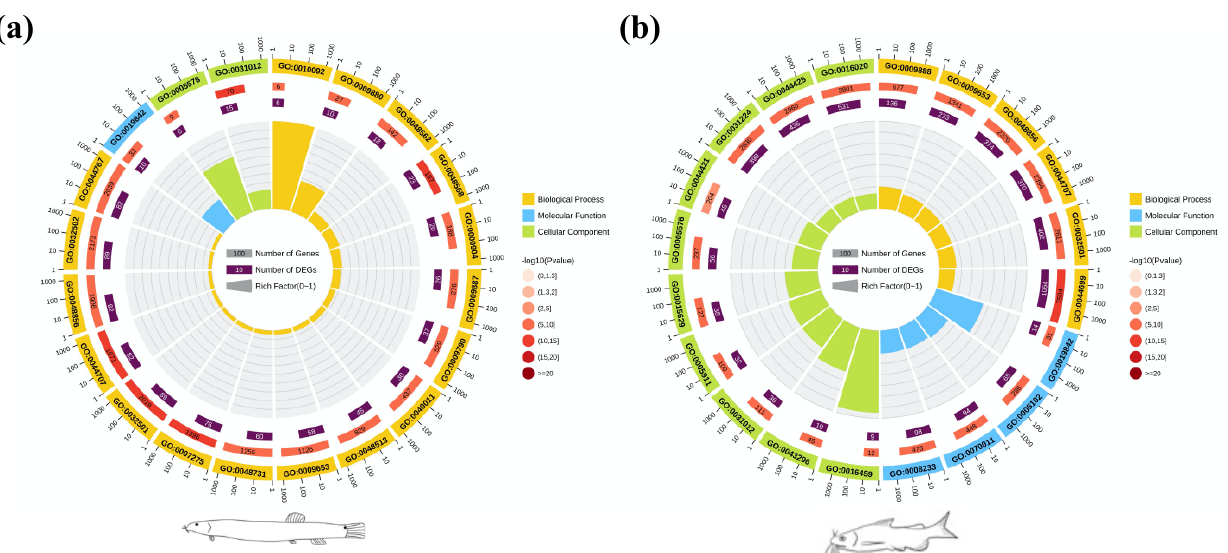
Figure 3. Top 20 of GO classifications enriched in the differentially expressed genes (DEGs) in comparisons of RS/OS pertain to loach ( a ) and yellow catfish ( b ). RS: regenerated skins; OS: original skins. The first circle from outside indicates gene number scale and GO items present by GO ids; Second circle indicates gene numbers under each GO item, and third circle shows enriched gene number of DEGs. The concentric circles represent rich factors of each GO item, which are equal to the ration of gene number of DEGs and background gene number under each GO item.